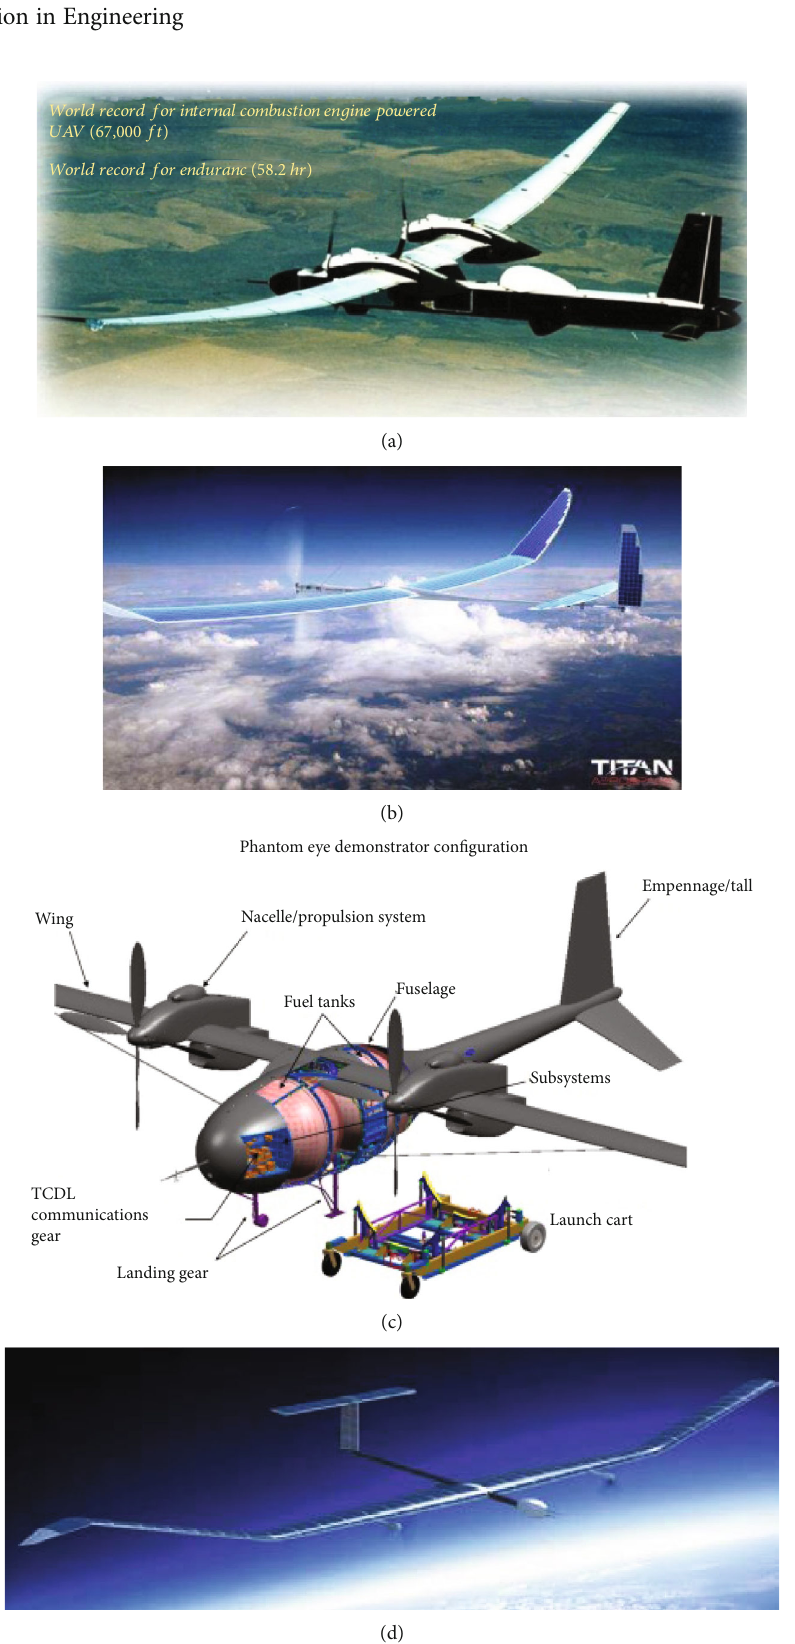
Figure 1: Pseudosatellite